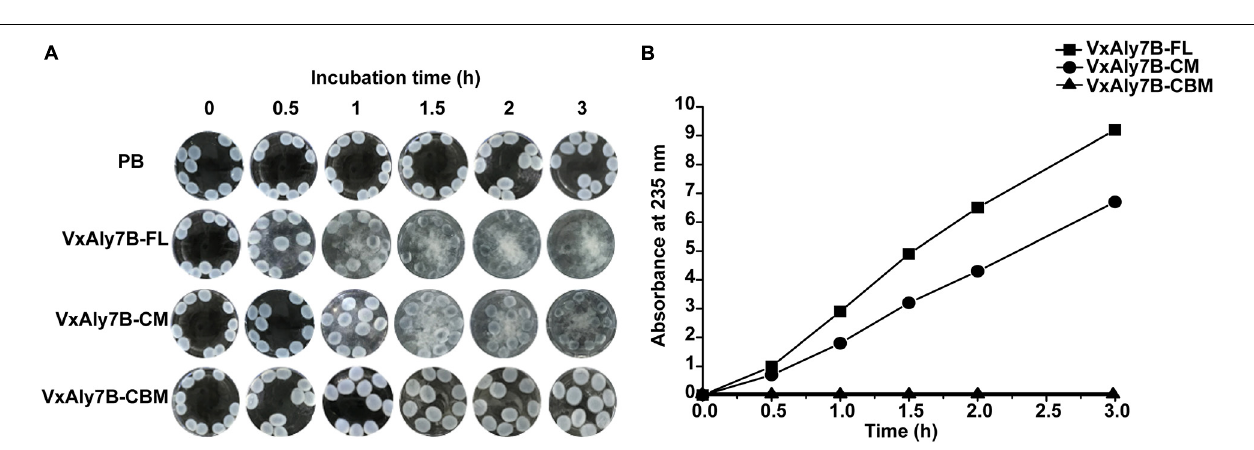
FIGURE 4 | Native affinity PAGE of recombinant VxAly7B-FL and VxAly7B-CM and binding effect of CBM32 on alginate gel beads. (A,C) The control gel was a gel without substrate. (B,D) Native affinity PAGE was performed using polyacrylamide gels containing sodium alginate. BSA was used as a control protein. Lane M, high molecular weight native electrophoresis protein marker II (45–669 kDa); Lane 1, recombinant VxAly7B-FL; Lane 2, recombinant VxAly7B-CM. (E) Binding abilities of recombinant VxAly7B-FL, VxAly7B-CM, and VxAly7B-CBM to alginate gel beads resolved by SDS-PAGE. Lane M, molecular weight markers; Lane 1, recombinant VxAly7B-FL; Lane 2, recombinant VxAly7B-CM; Lane 3, recombinant VxAly7B-CBM.